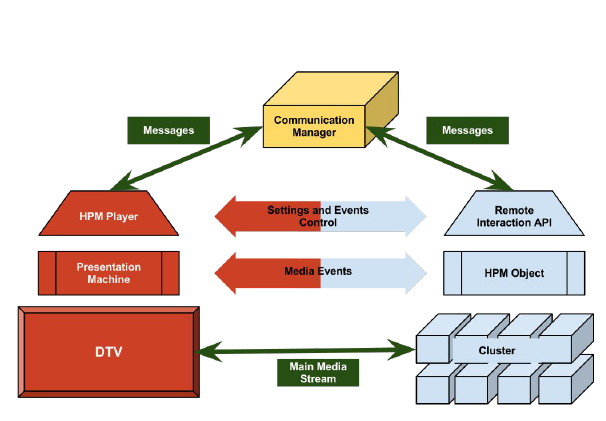
Figure 4. HPM Architecture